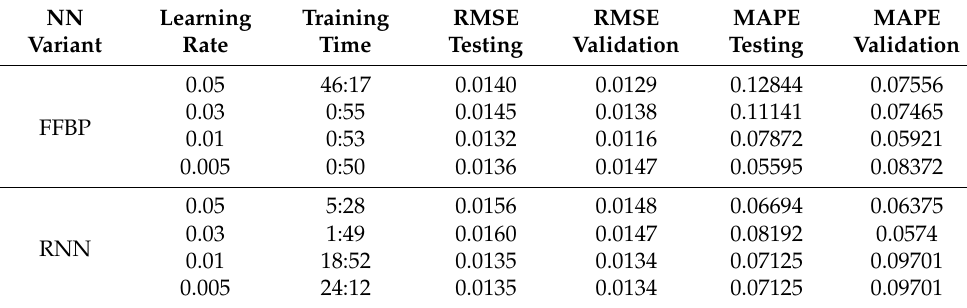
Figure 4. Testing error between estimated and target values for Case 1. The RMSE of 1.32% was the lowest in the case of FFBPNN for the learning rate of 0.01. RNN showed the best performance with the MAPE score of 6.69% and the